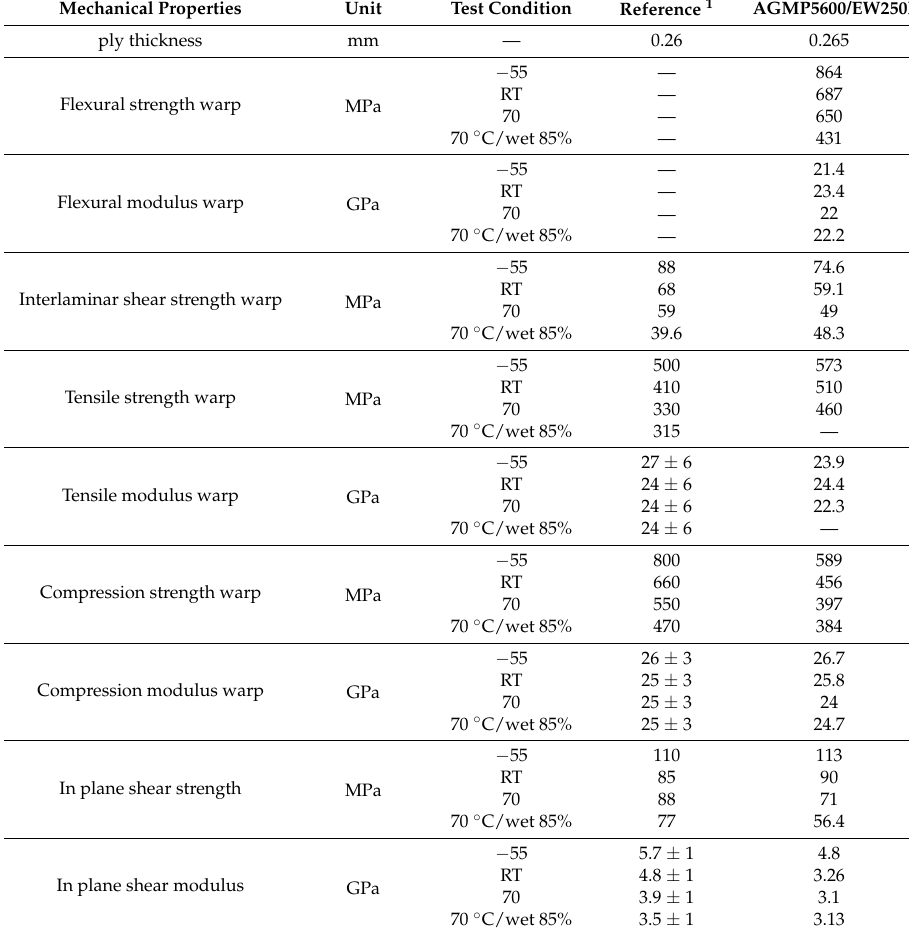
Table 4. Mechanical properties of AGMP5600/EW250F (glass fabric, 8 satin, 47 vol %), a 180 ◦ C cure rosin-sourced epoxy laminate, under different hydrothermal